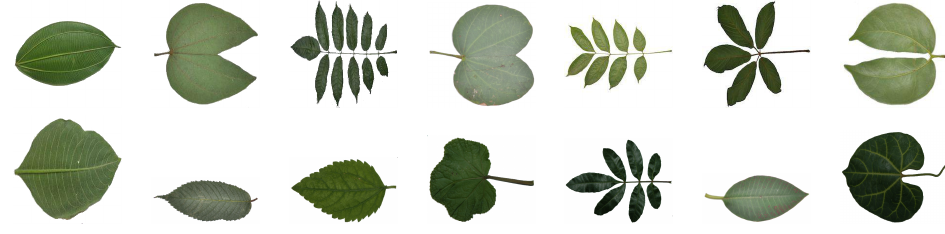
Figure 3. Some images of the CR LEAVES